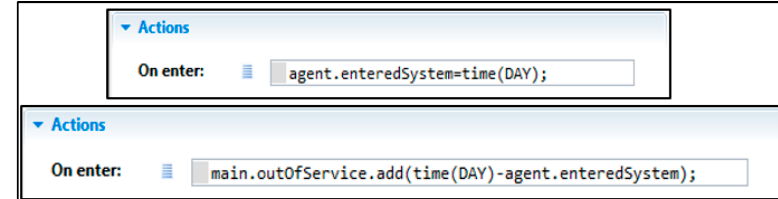
Figure 10. Determine the out of service time in ABSM.